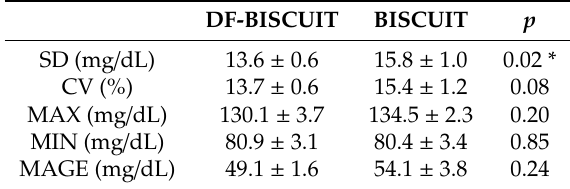
Table 3. Glucose parameters in both trials.